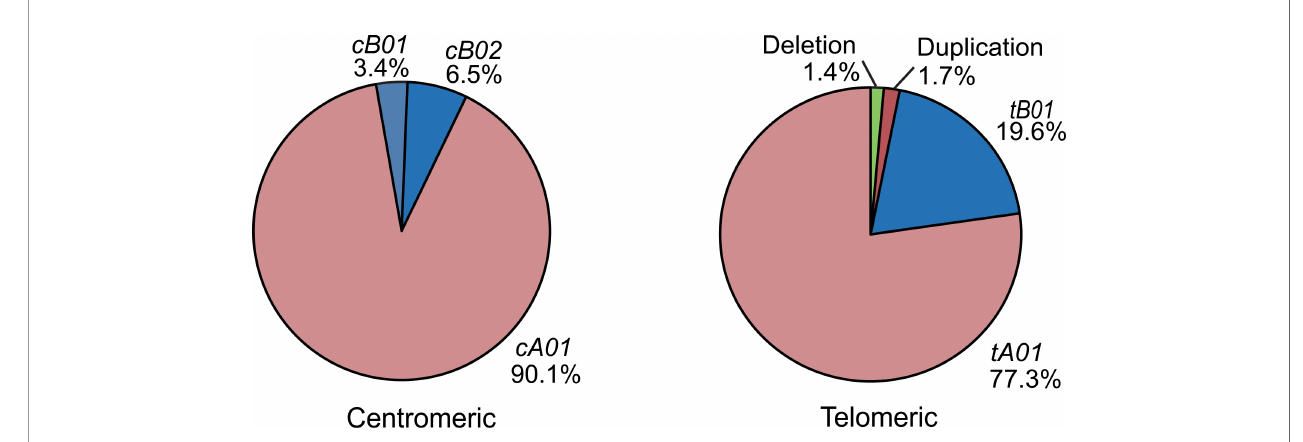
FIGURE 4 | Distribution of Cen-A/B and Tel-A/B haplotypes in the